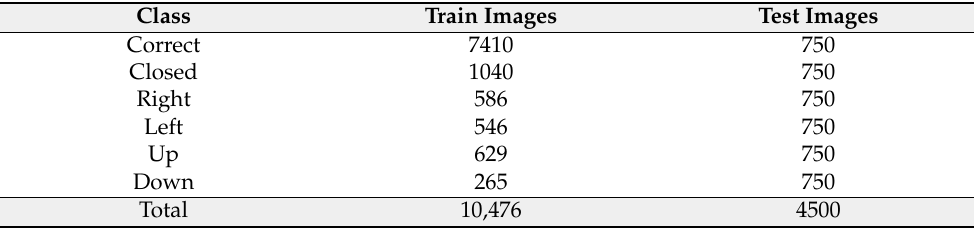
Table 3. Train and test splitting used in PopEYE dataset for both ML and DL approaches. Class Train Images Test